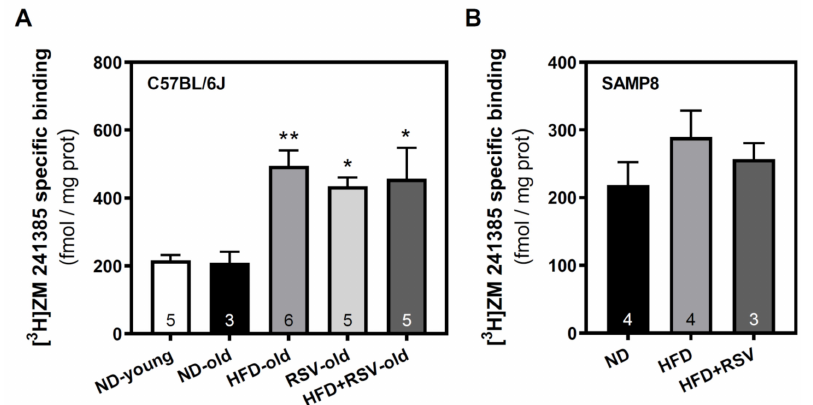
Figure 3. Adenosine A 2A receptor level in the cerebral cortex. Radioligand binding assays were carried out in plasma membrane fractions of C57BL/6J ( A ) and SAMP8 ( B ) mice to assess the modulation of this receptor. [ 3 H]ZM 241385, at a saturated concentration of 20 nM, was used as selective radioligand and nonspecific binding was determined in the presence of 3 mM theophylline as described in Methods. Data are mean ± SEM of three-six different samples (indicated within the bars).